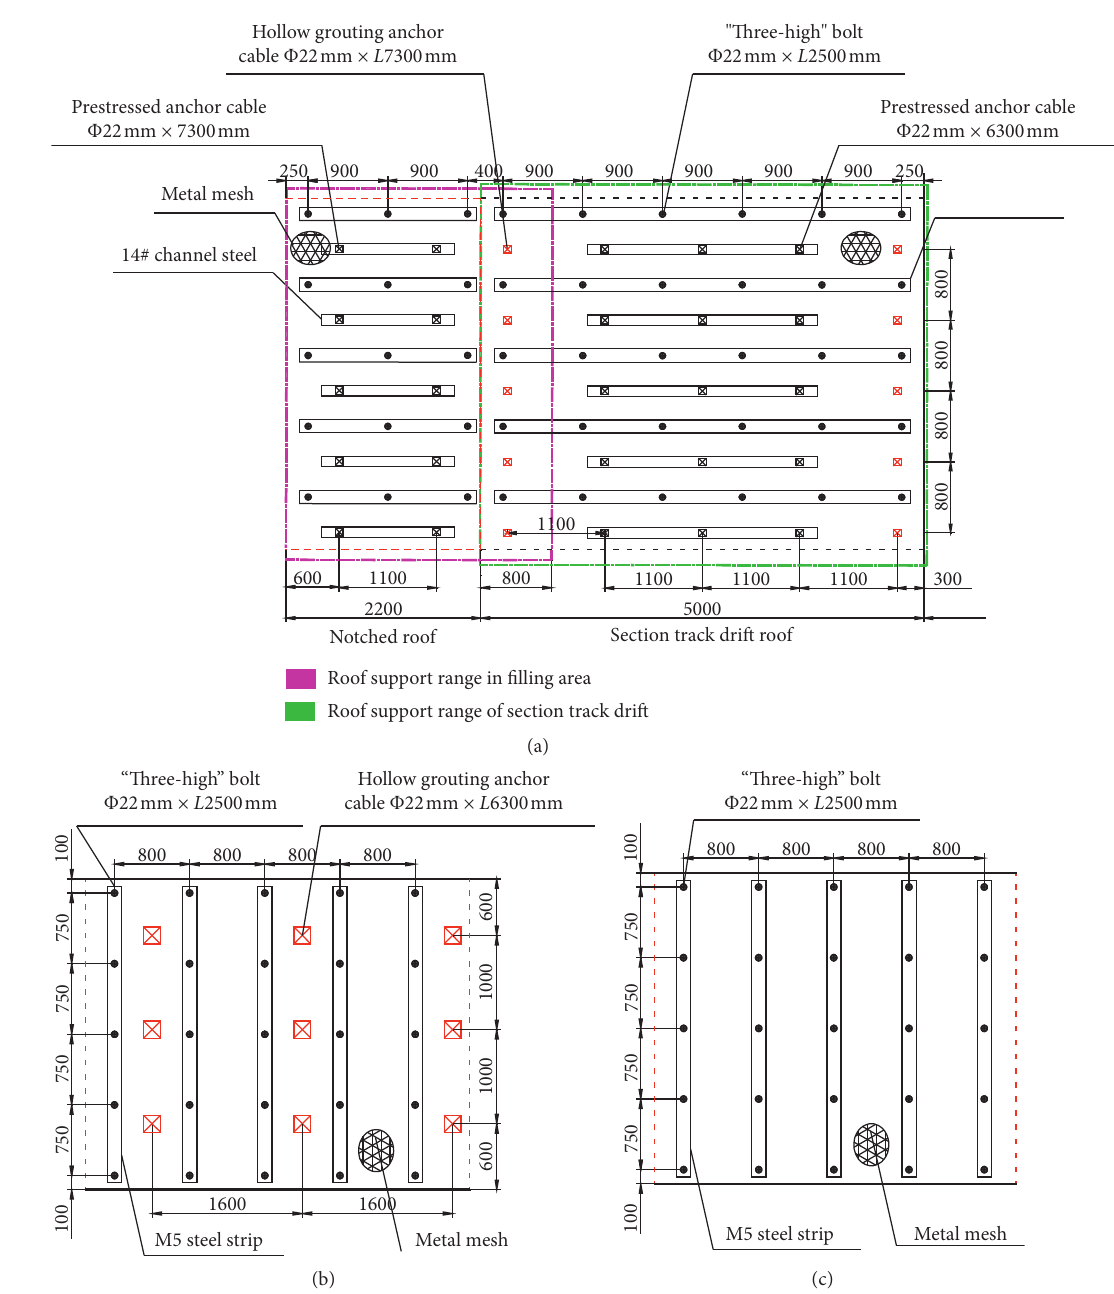
Figure 11: Support scheme of surrounding rock. (a) Support parameters of roadway roof, (b) support parameters of solid coal side, and (c) support parameters of coal